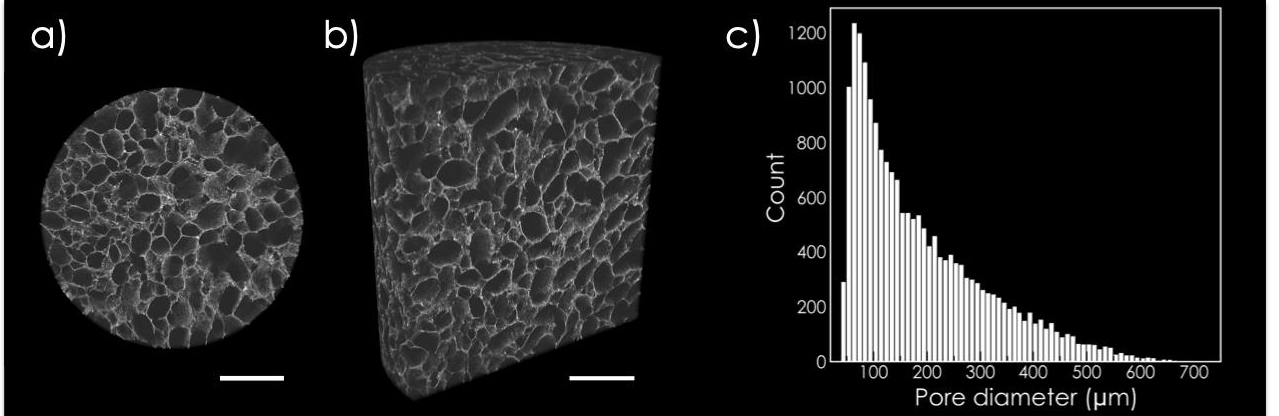
Figure 1. Structural characterization of recombinant collagen in the presence of magnesium (RCP.MgAp) scaffold (diame- ter = 4 mm; height = 4 mm) by micro-computed tomography. ( a ) Transversal and ( b ) longitudinal section of the scaffold. Scale bar=1 mm. ( c ) Graph bar displays pore size distribution estimated with ImageJ software.